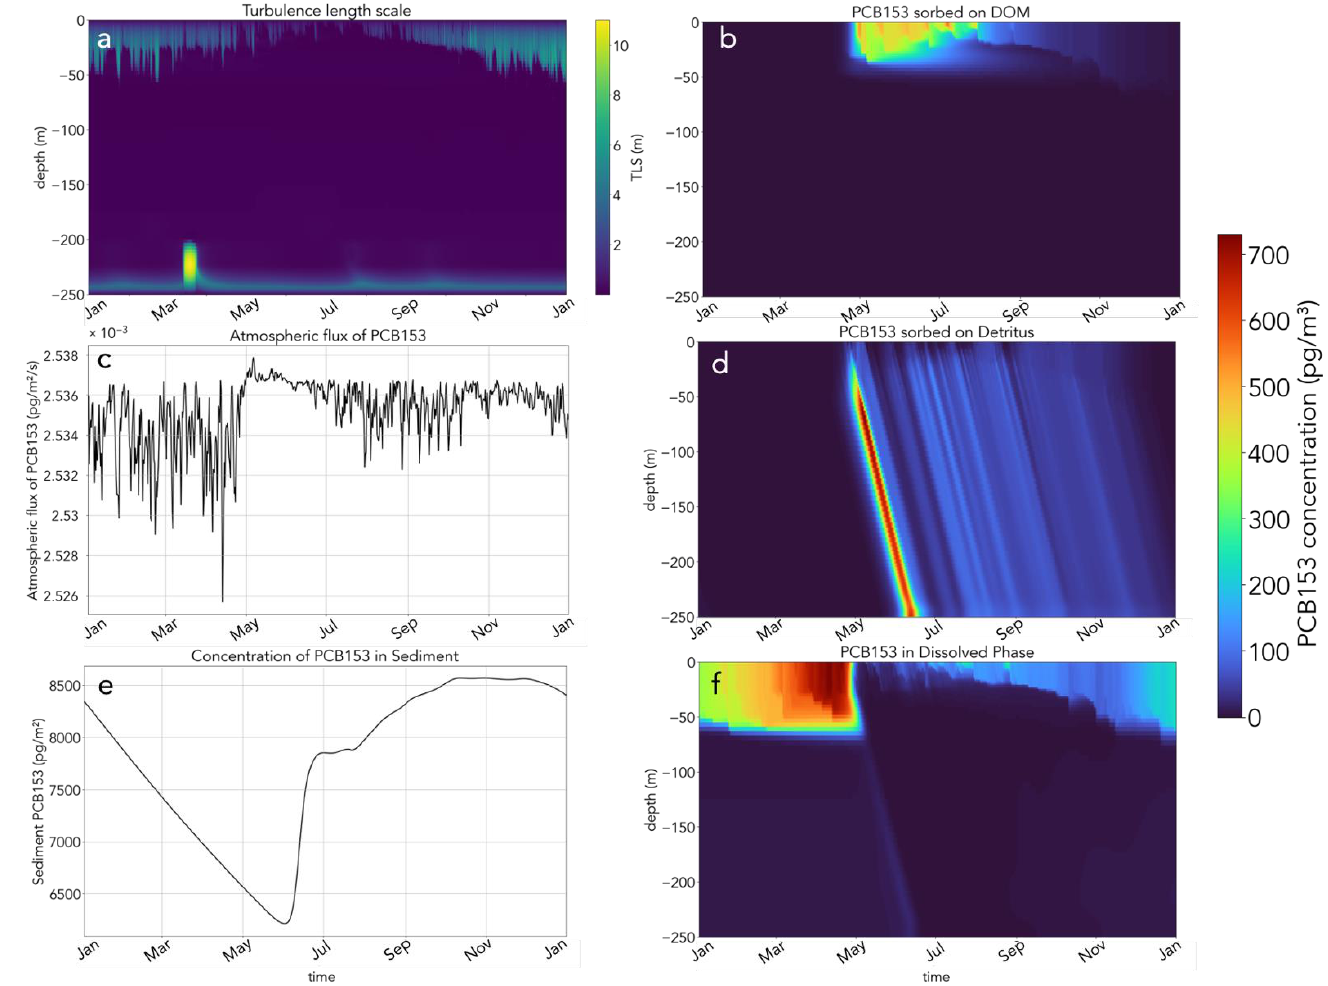
Figure 6. Results of simulation in the Gotland Basin (year 2001): ( a ) — TLS (m); ( b ) — PCB DOM concentrations (pg m −3 ); ( c ) — atmospheric flux of PCB 153 (pg m −2 s −1 ) (direction of flux — from atmosphere to water); ( d ) — PCB POM concentrations (pg m −3 ); ( e ) — sediment concentration of PCB (pg m −2 ); ( f ) — PCB free concentration (pg m −3 ).